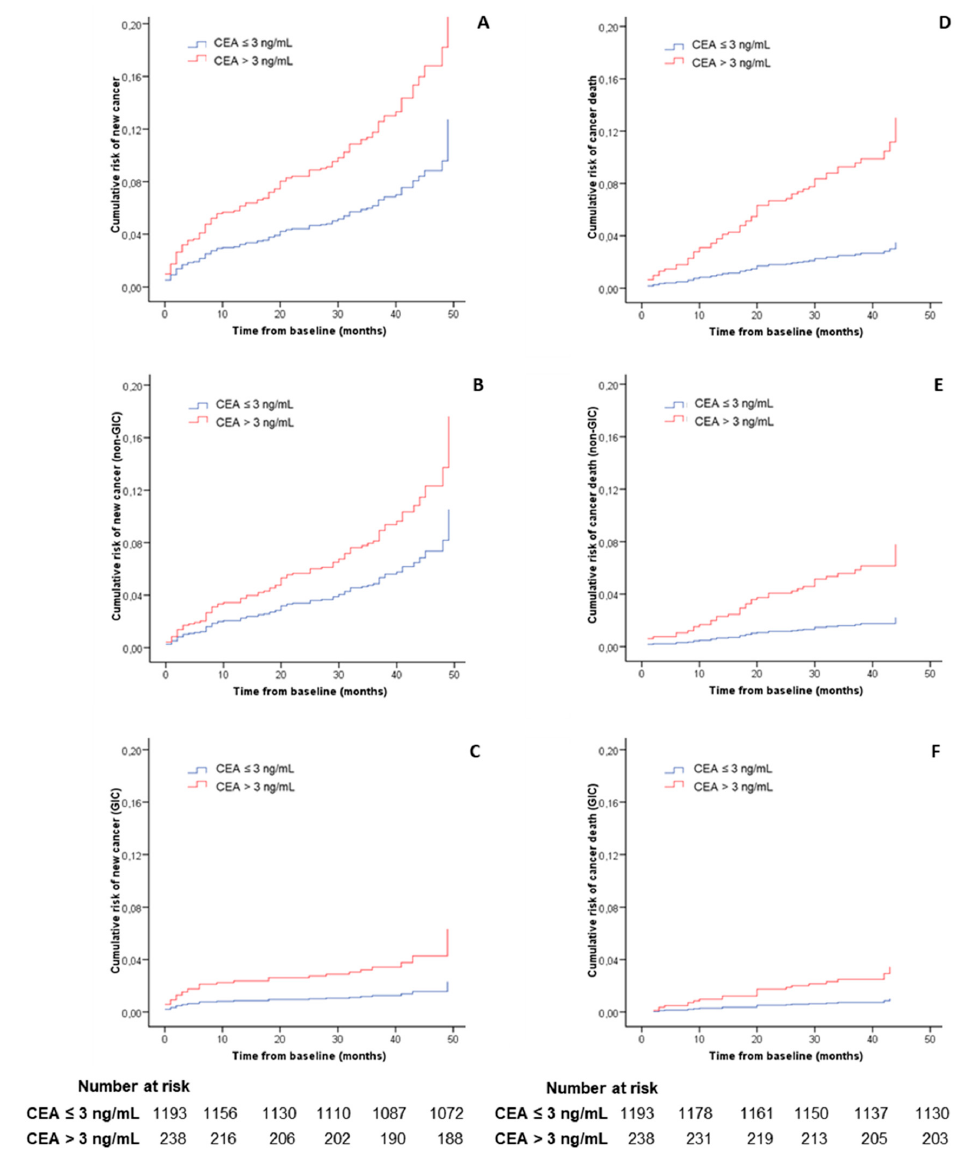
Figure 2. Cumulative risk of cancer and related death. Cumulative risk of cancer and related death during follow-up after baseline evaluation according to carcinoembryonic antigen value and adjusted by sex, age and the presence of advanced adenoma. The figure is calculated with a Cox’s multivariable regression. ( A ) Risk of cancer diagnosis (global cancer); ( B ) risk of non-gastrointestinal cancer diagnosis; ( C ) risk of gastrointestinal cancer diagnosis; ( D ) risk of new cancer-related death; ( E ) risk of new non-gastrointestinal cancer death; ( F ) risk of new gastrointestinal cancer death. Number at risk was calculated for global cancer diagnosis and new cancer related death, respectively.